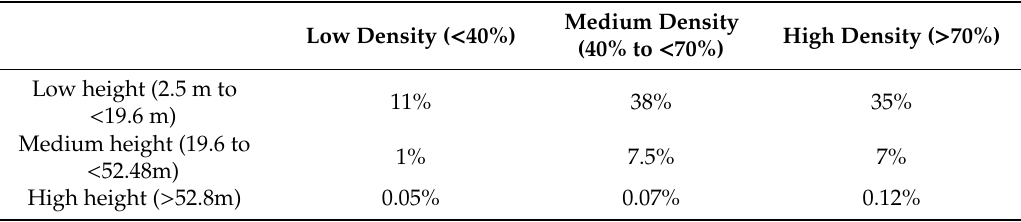
Table 4. Landscape pattern.